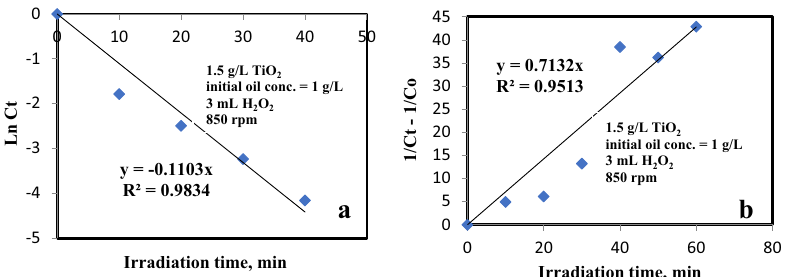
where C o is the initial concentration of oil and C t is the concentration at irradiation time t, K 1 and K 2 are first and second order rate constants in min −1 and L g −1 min −1 , respectively, t is the degradation time (in min). A plot ln